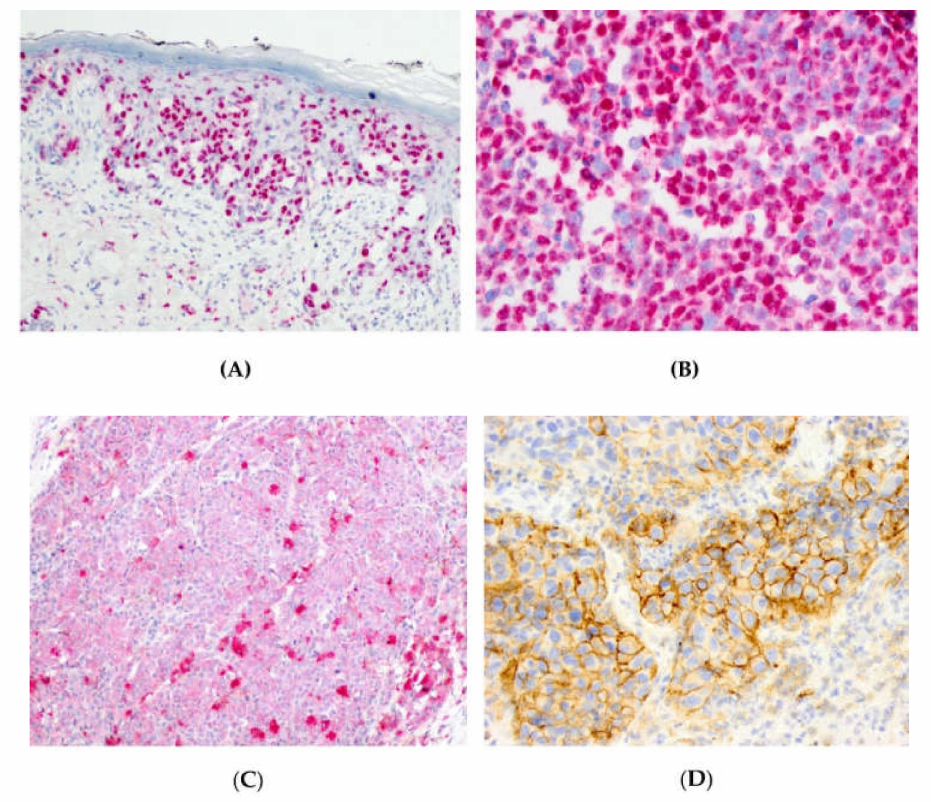
Figure 2. Nuclear PARP1 expression within an in situ ( A ) and invasive ( B ) component of a vulvar melanoma. Cytoplasmic IDO1 expression in anorectal melanoma ( C ). Membranous PD-L1 expression in a sinonasal melanoma ( D ). Table 1. Summary of clinicopathologic variables versus PAPR1, PD-L1, and IDO1